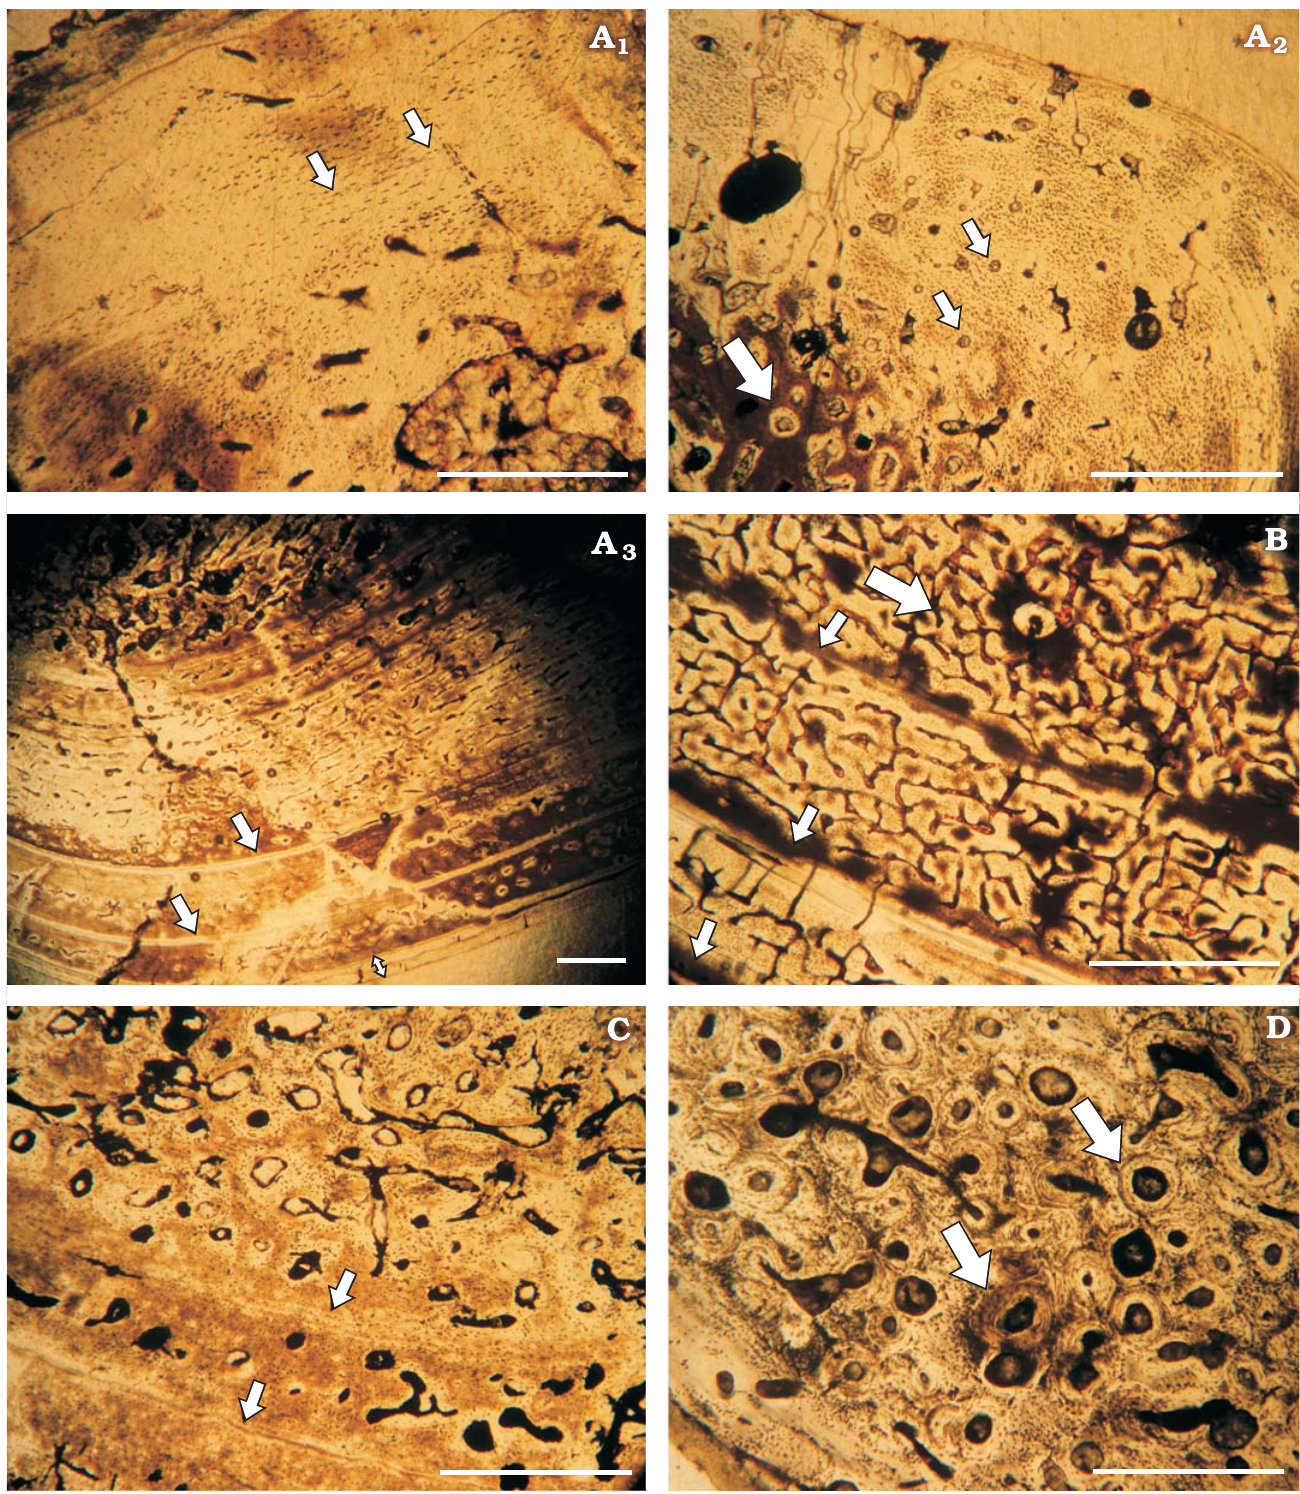
Fig. 1. Transverse section of hyperodapedontine rhynchosaurs Teyumbaita sulcognathus Montefeltro, Langer and Schultz, 2010 ( A – C ) and Hyperodapedon sp. ( D ) from Santa Maria Supersequence, Santa Maria 2 Sequence, Rio Grande do Sul, Brazil, Upper Triassic. A . UFRGS-PV-0298-T, radius, cortex showing a more organized parallel-fibred region (arrows) (A ); rib, cortex showing primary (arrows) and secondary (big arrow) osteons (A ); humerus, 1 2 lamellar-zonal bone with growth marks (arrows) and the EFS (double-headed arrow) on the external surface of the cortex (A ). B . UFRGS-PV-0232-T, 3 tibia, fibrolamellar bone tissue in the perimedullary region (big arrow) and three growth marks (arrows) near the periosteal surface. C . UFRGS-PV- 0290-T, tibia showing the growth marks present in the parallel-fibred region (arrows). D . UFRGS-PV-0247-T, rib showing the secondary osteons (big arrows) in the perimedullary region. Scale bars 1